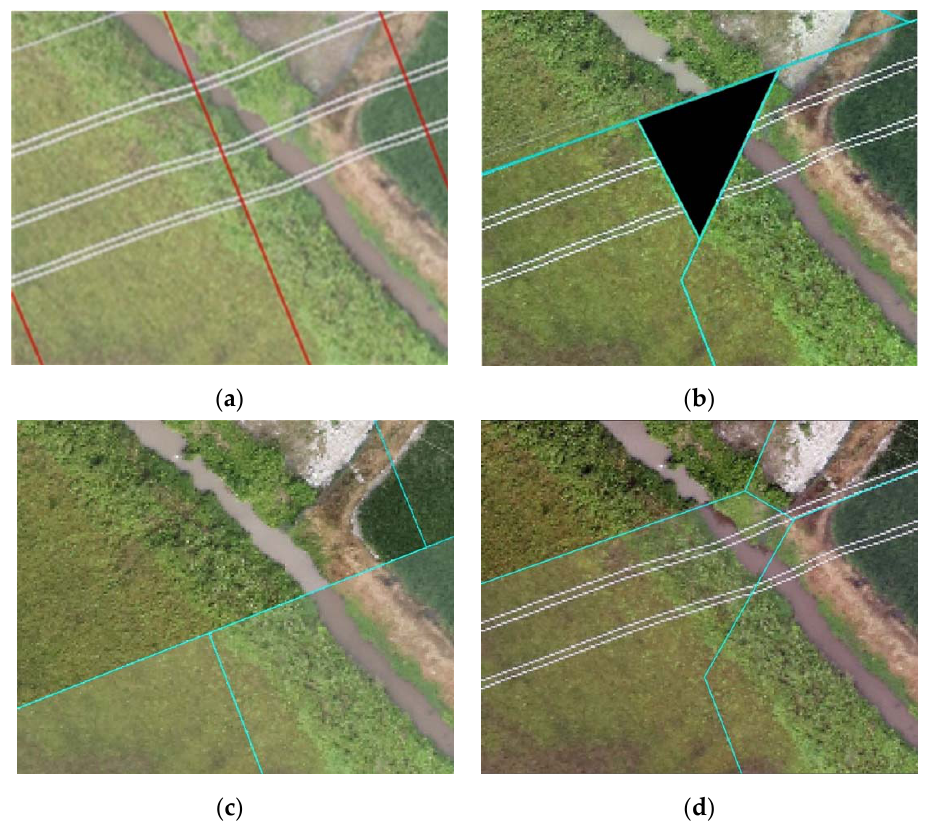
Figure 13. Details of ( a ) the blue rectangular area marked in Figure 8; ( b ) the blue rectangular area marked in Figure 12a; ( c ) the blue rectangular area marked in Figure 12b; ( d ) the blue rectangular area marked in Figure 9.